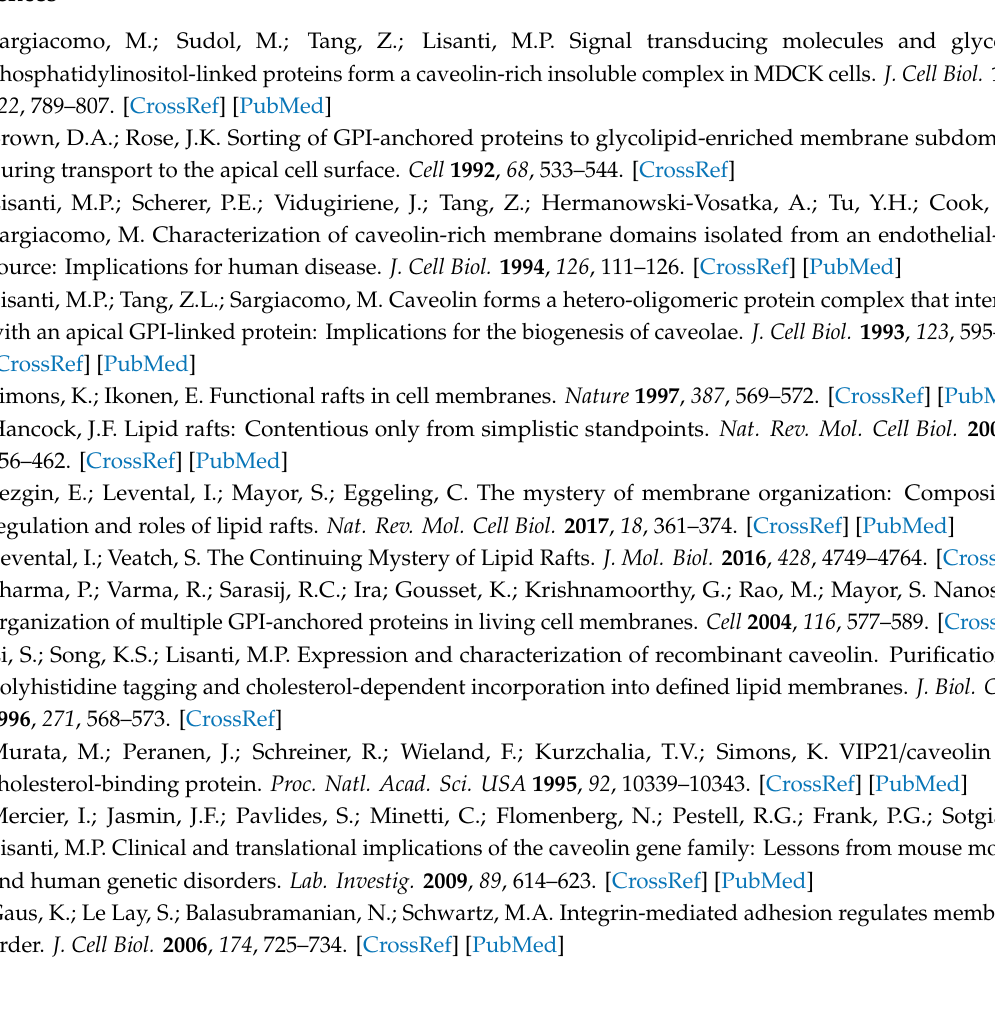
Table S1: Proteome of WT and Cav-1 KO DRMs from mouse lungs; Table S2: Fatty acid composition of DRMs; Figure S1: Cav-1 insertion in protein-free WT DRMs derived liposomes; Figure S2: Characterization of DRMs lipids; Figure S3: X-ray scattering analysis of DRMs from WT and Cav-1 KO mouse adipose